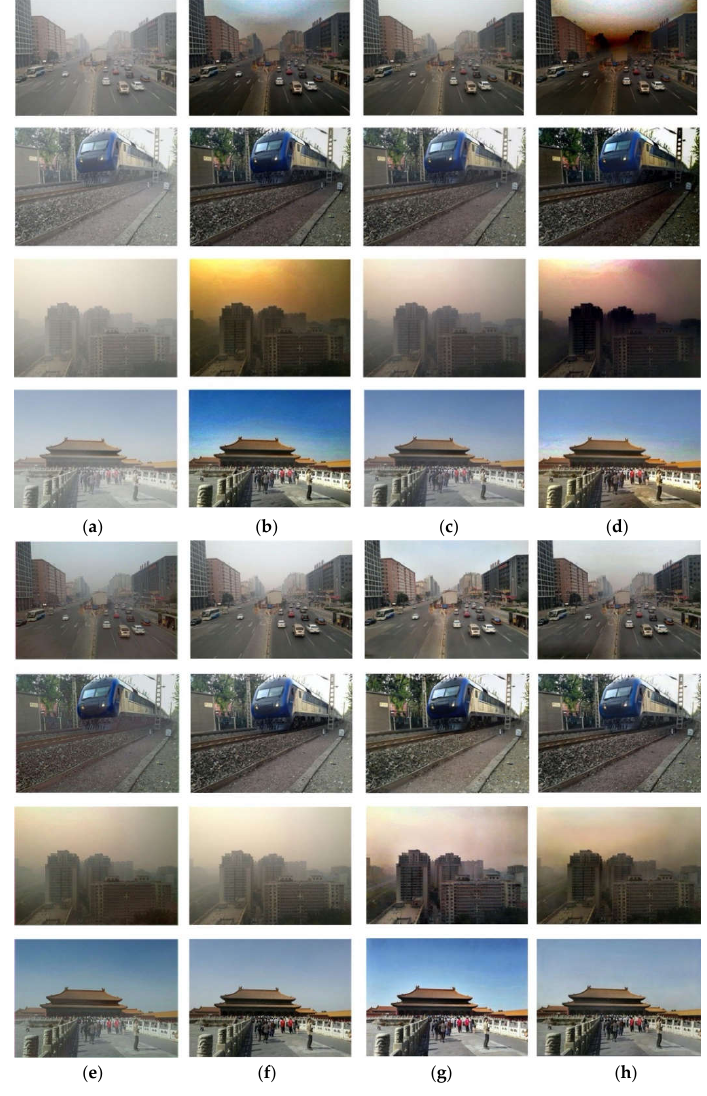
Figure 6. Dehazing effect of different dehazing algorithms on the SOTS dataset. ( a ) Input image; ( b ) DCP [12]; ( c ) CAP [13]; ( d ) DehazeNet [16]; ( e ) AOD-Net [18]; ( f ) MSBDN [21]; ( g ) DA-dahazing [26]; ( h ) Ours.